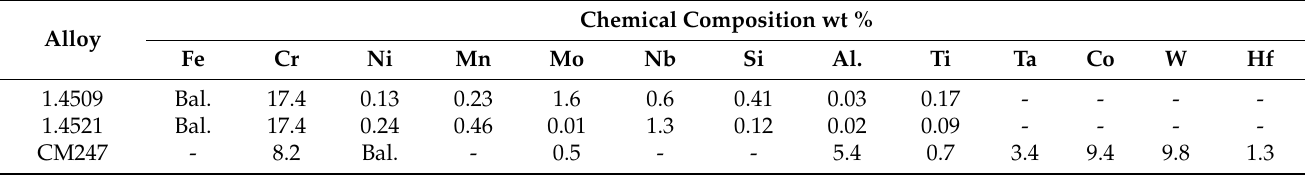
Table 1. Chemical composition of studied materials in wt